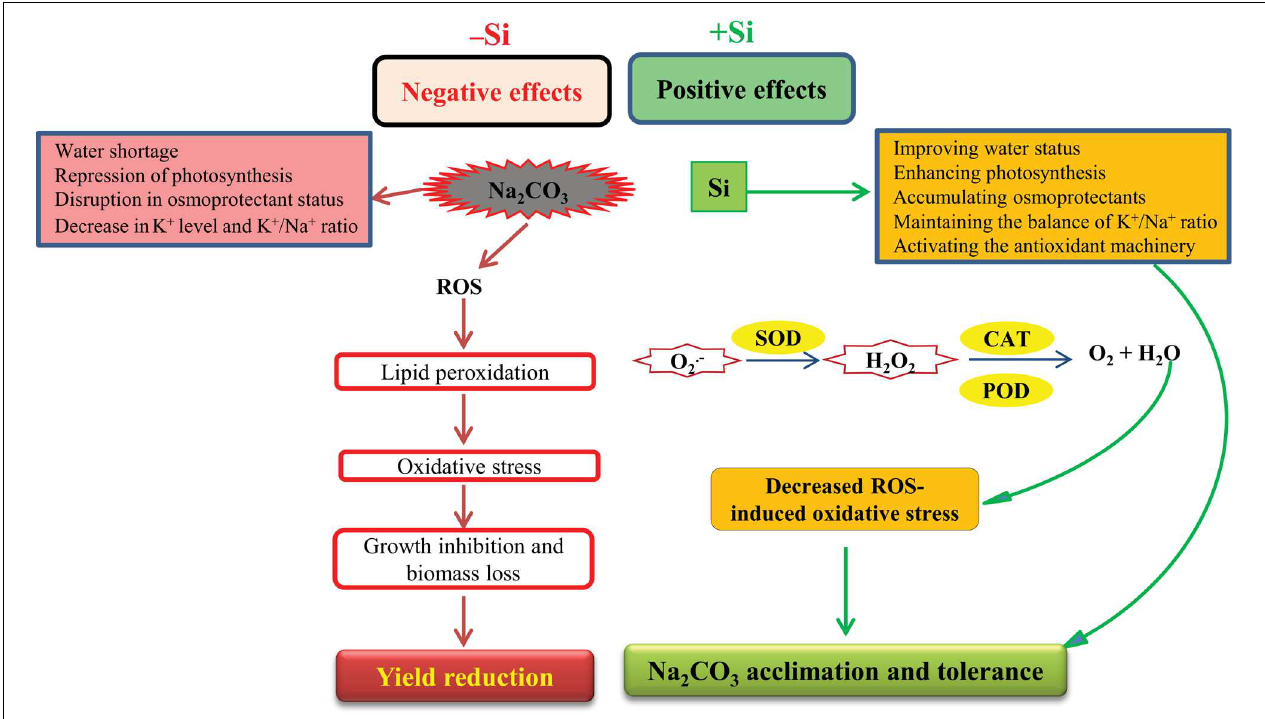
FIGURE 4 | A schematic diagram representing effects of alkaline stress (e.g., Na 2 CO 3 stress) and defensive system induced by seed-priming with Si, underlying maize alkaline stress tolerance. Alkaline stress causes negative impacts by repressing photosynthesis, disrupting osmoprotectant status and negatively influencing water status and ionic balance. Excessive alkalinity can promote production of reactive oxygen species (ROS). ROS contribute to lipid peroxidation, resulting in oxidative stress that causes growth inhibition, biomass loss, and subsequently extreme yield reduction. Conversely, seed-priming with Si shows protective mechanism against alkaline stress by improving water balance and photosynthesis, accumulating osmoprotectants and maintaining ionic balance. Si also enhances the detoxification of ROS by stimulating the activities of antioxidant enzymes, such as SOD, CAT, and POD, leading to oxidative stress mitigation. As a result, Si improves alkaline stress tolerance by retaining better growth of alkaline-stressed plants. O •− 2 , superoxide; H 2 O 2 , hydrogen